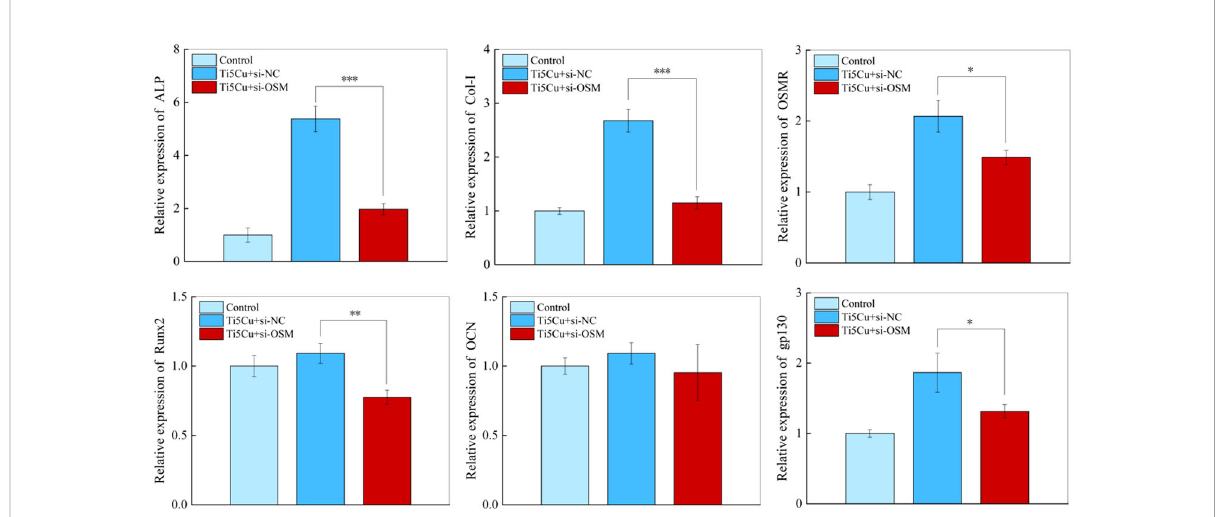
FIGURE 12 The expressions of osteogenic genes and OSM-related receptors genes of MC3T3-E1 cells after cultured with si-NC and si-OSM conditioned medium for 7 days by RT-qPCR (n = 3; *p < 0.05, **p < 0.01, and ***p <